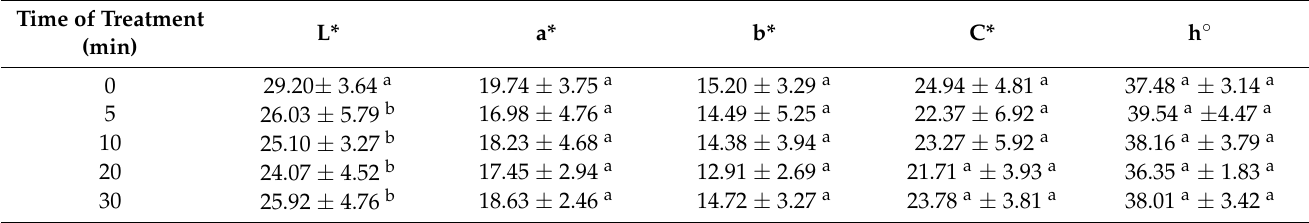
Table 4. Instrumental color in the CIE L*a*b*